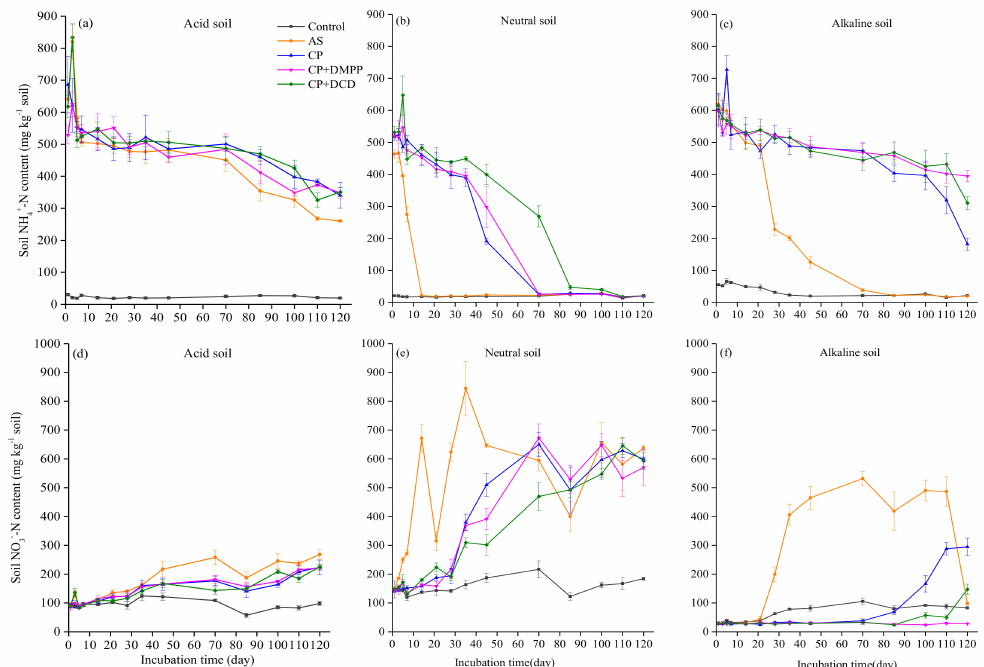
Figure 2. Changes in ammonium nitrogen (NH 4+ -N) and nitrate nitrogen (NO 3 − -N) in the acid ( a , d ), neutral ( b , e ), and alkaline soil ( c , f ) among different treatments during 120 days of incubation. Treatments: Control: No fertilizer and NIs; AS: Ammonium sulfate; CP: Ammonium sulfate + nitrapyrin; CP+DMPP: Ammonium sulfate + nitrapyrin + 3,4- dimethylepyrazole phosphate; CP+DCD: Ammonium sulfate + nitrapyrin + dicyandiamide. Error bars represent standard deviations (n = 3). The same as below.